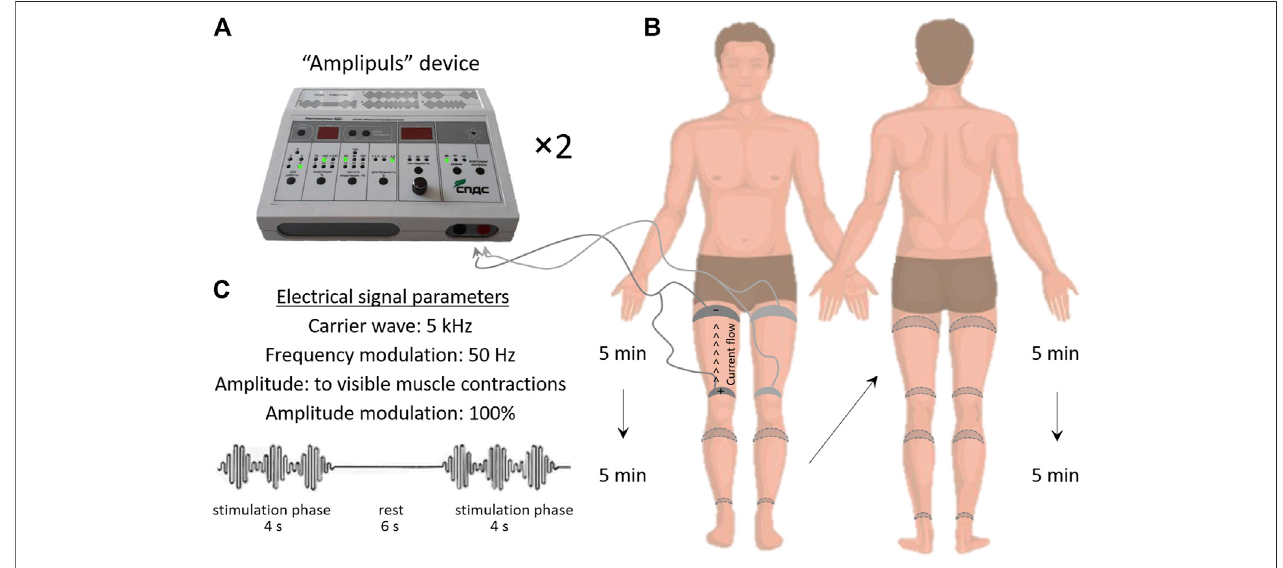
FIGURE 2 | Main indicators from the Tinetti test. (A) , Rivermead Mobility Index (B) ,UpandGo (C) ,Strength (D) .Mean±SEM.** p < 0.002prevs.post.